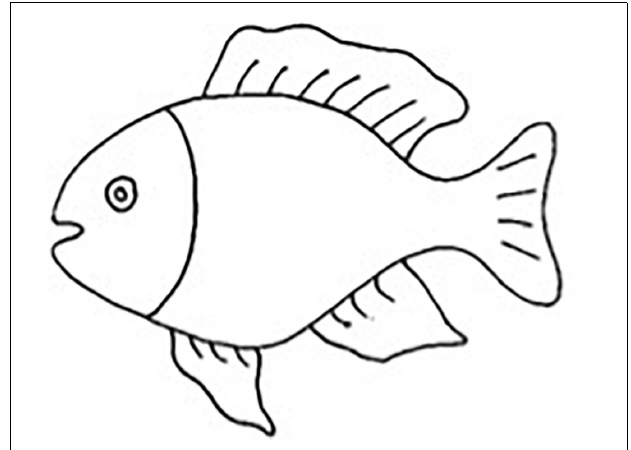
FIGURE 3 | An example of a gender-neutral fish used in the Derivational Suffix comprehension